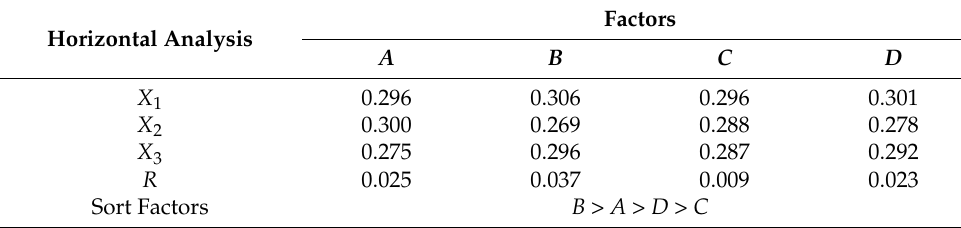
Table 7. Range analysis of the wood basic density of dyed red-heart Chinese fir